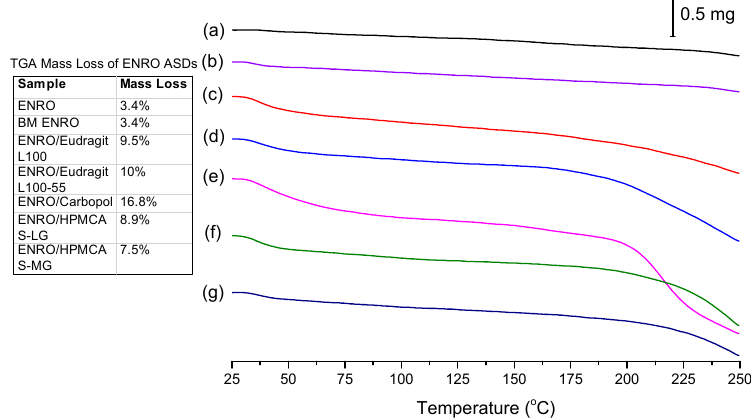
Figure 5. TGA analysis of ( a ) crystalline ENRO, ( b ) ball milled (BM) ENRO, ( c ) ENRO/Eudragit L100, ( d ) ENRO/Eudragit L100-55, ( e ) ENRO/Carbopol, ( f ) ENRO/HPMCAS-LG, and ( g ) ENRO/HPMCAS- MG.